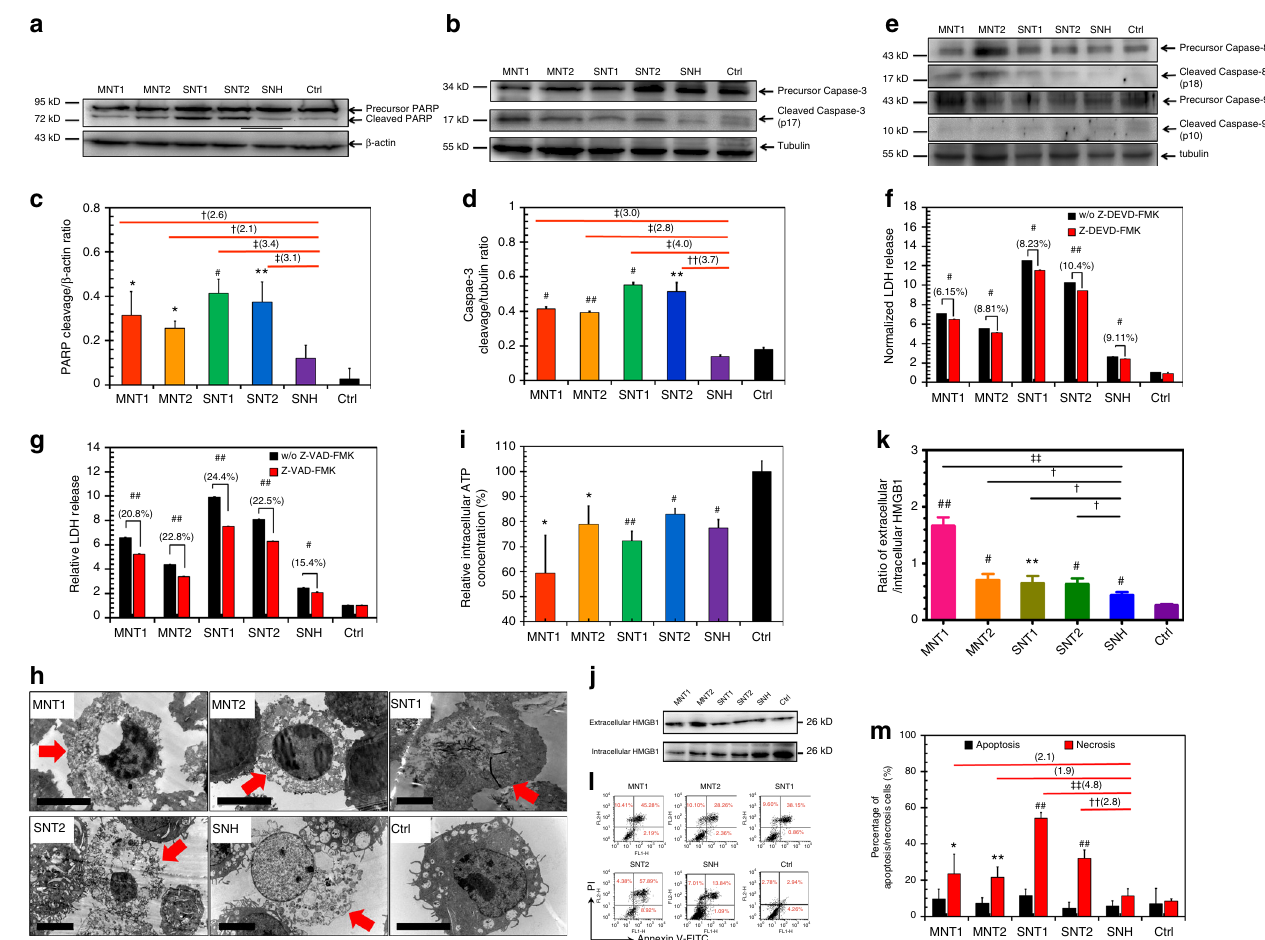
Fig. 3 SNH-induced less apoptosis and necrosis than CNT. a , b Western blot analyses of a PARP and b caspase-3 cleavages after different nanocarbon incubations. c , d Quantitative cleavage ratio measurements of c PARP and d caspase-3 in nanocarbon-incubated cells according to the integrated optic density (IOD) value detection based on western blot imaging ( n = 3). e Western blot analyses of caspase-8 and caspase-9 cleavages after nanocarbon incubations. f , g Cytotoxicity detections of different nanocarbons with and without two caspase inhibitors, f Z-DEVD-FMK and g Z-VAD-FMK) ( n = 4). h Transmission electron microscopy images of dead cells caused by different nanocarbons. Red arrows showed the typical necrosis characteristics of cells. Scale bar: 5 μ m. i Intracellular ATP detection after nanocarbon incubations ( n = 4). j Immunoblot analysis of extracellular and intracellular HMGB1 after cellular incubations with different nanocarbons. k Quantitative ratio of extracellular HMGB1 to intracellular HMGB1accorind to the IOD detection based on WB imaging ( n = 3). l Flow cytometry analysis of cells based on Annexin V/PI assay after nanocarbon incubations. m Quantitative comparison of apoptosis and necrosis caused by different nanocarbons detected by apoptosis/necrosis assay kit ( n = 4). In c , d , f , g , i , k and m , data were presented as means ± s.d. Statistical signi fi cances were calculated by Student ’ s t -test. In c , d , k , and m , data were compared with control (Ctrl) and SNH groups separately.